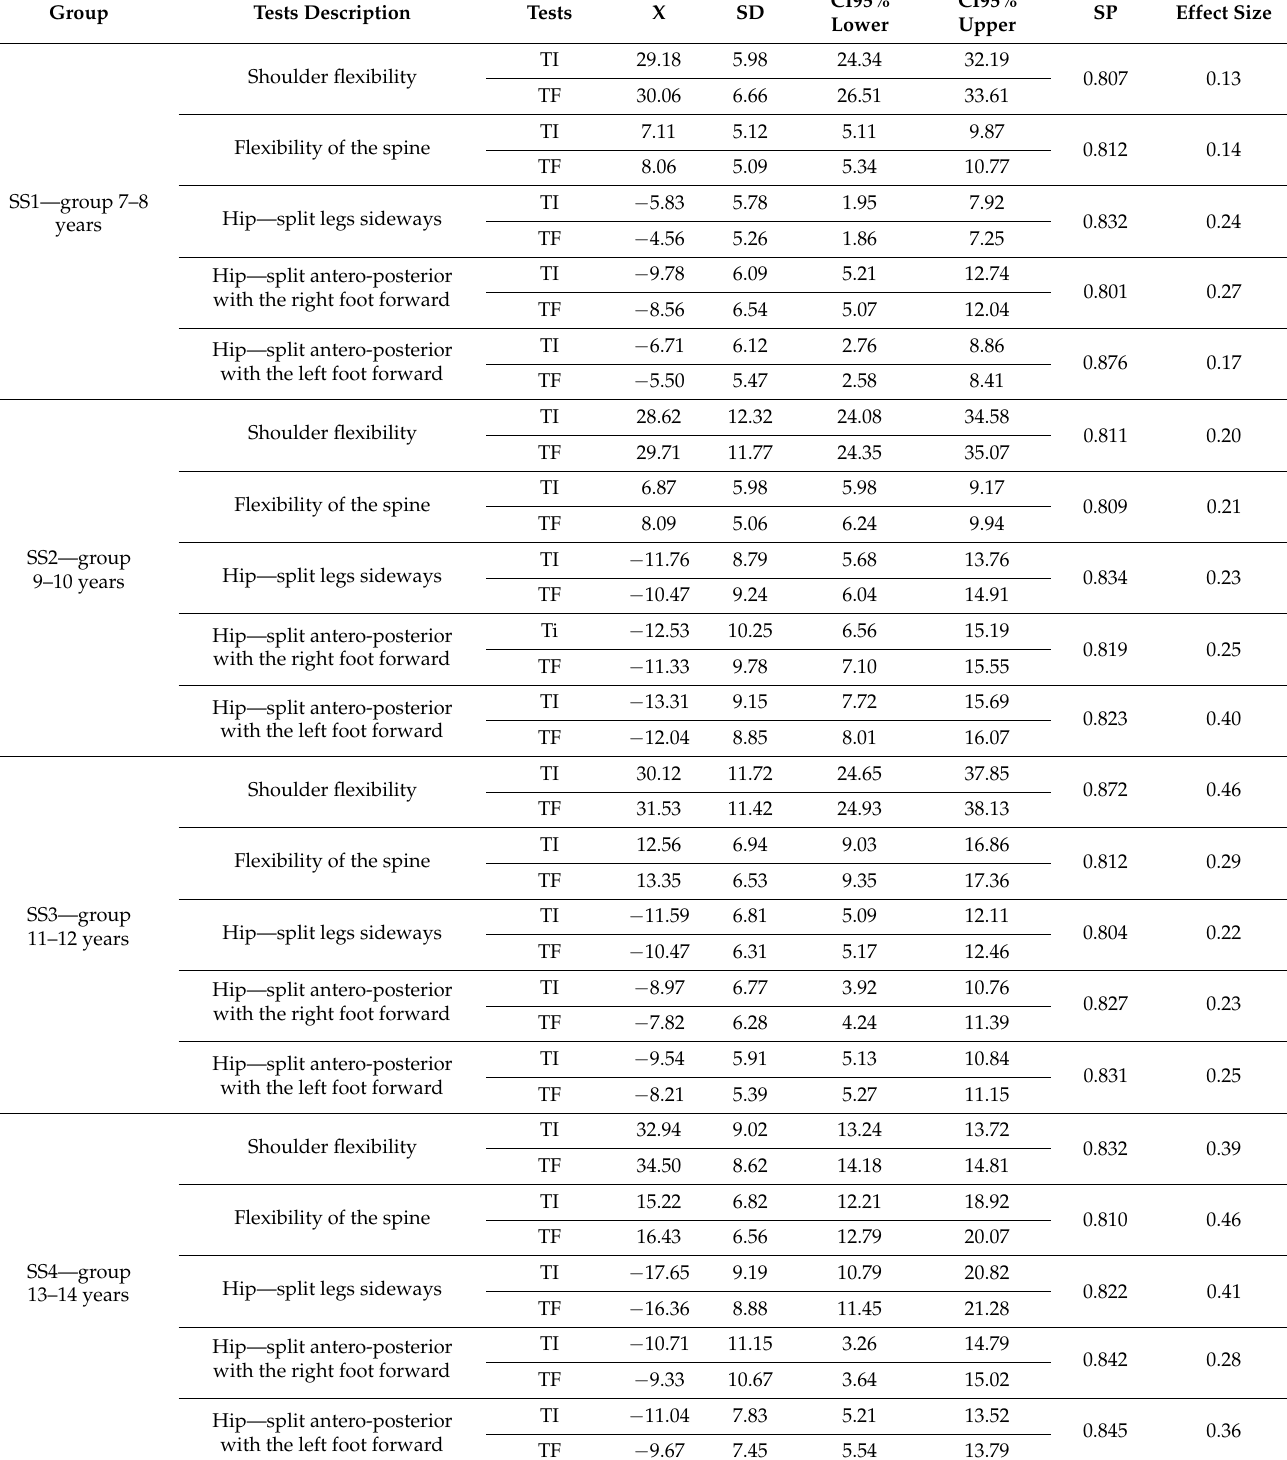
Table 4. Centralizer results in segmental mobility